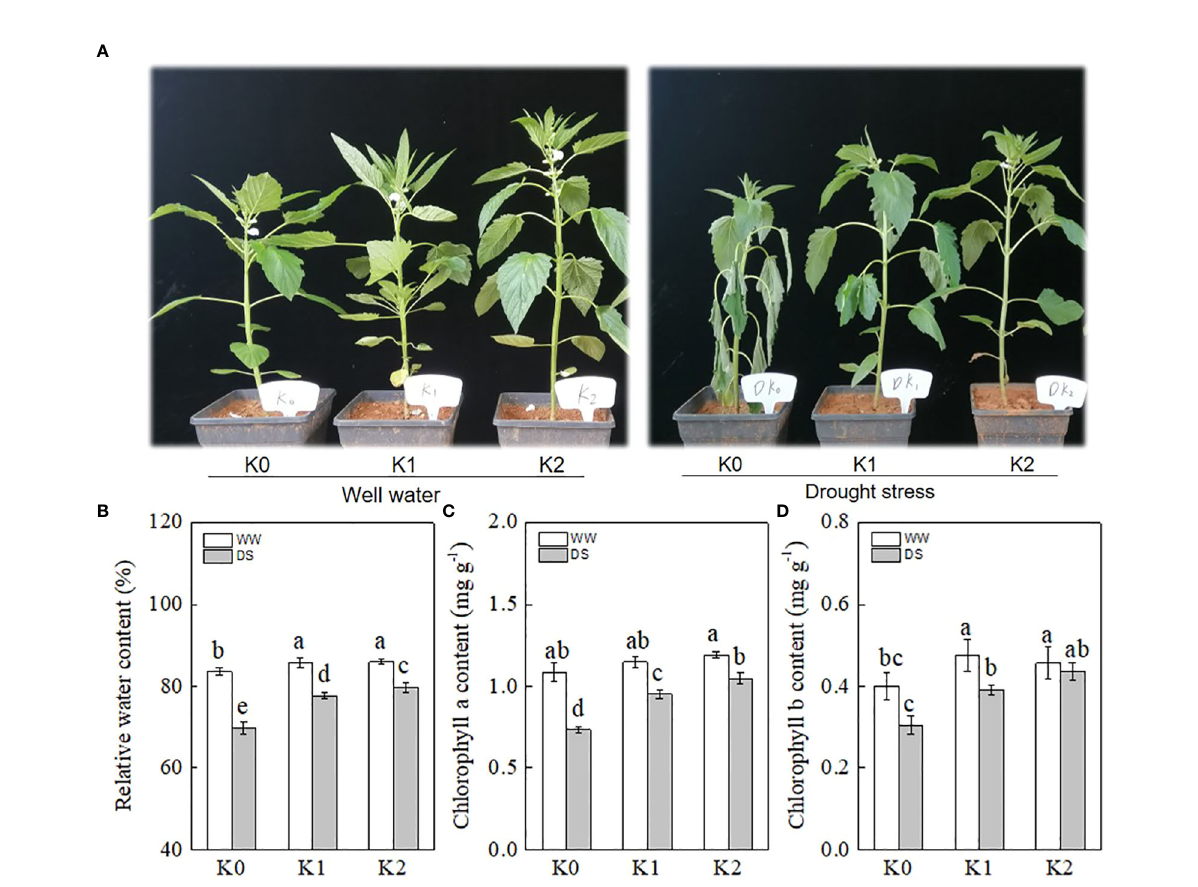
FIGURE 1 Effects of drought stress on phenotypic performance (A) , relative water content (B) , chlorophyll a (C) , and chlorophyll b (D) in sesame leaves at the fl owering stage under different K levels. K0, K1, and K2 represent K application rates at 0, 60, and 120 kg ha − 1 K 2 O, respectively. 3 d and 6 d indicate the sample date from the initiation of drought stress. Lowercase letters show signi fi cant differences at the P <0.05